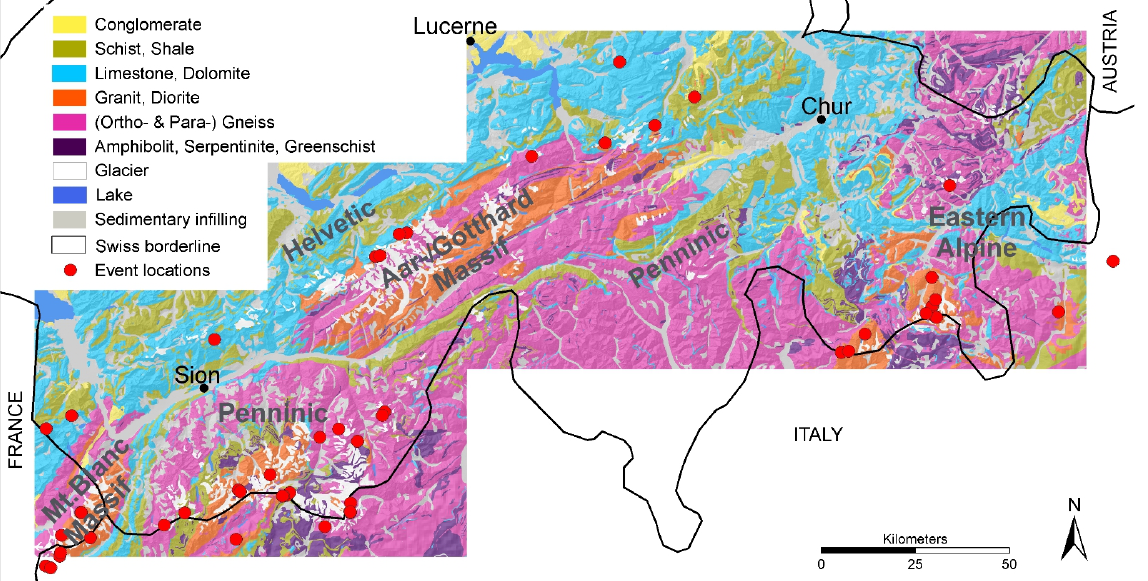
Fig. 3. Simplified geological classification of the Central Alps derived from the Geotechnical Environmental Atlas of Switzerland V1/00 (© Swiss Geotechnical Commission; Geological basis data© Swiss Federal Office of Topography, Section Geological Survey). Additionally, the main tectonic units are indicated. The class conglomerate contains sandstone, marl, breccias; schist/shale contains schist, shale, argillite, and similar lithologies; limestone/dolomite contains limestone and dolomite; granite/diorite contains mainly granitic lithologies and gabbro; gneiss contains both orthogneiss and paragneiss; amphibolite contains amphibolite, peridotite, serpentinite, greenschist (also called mafic metamorphic